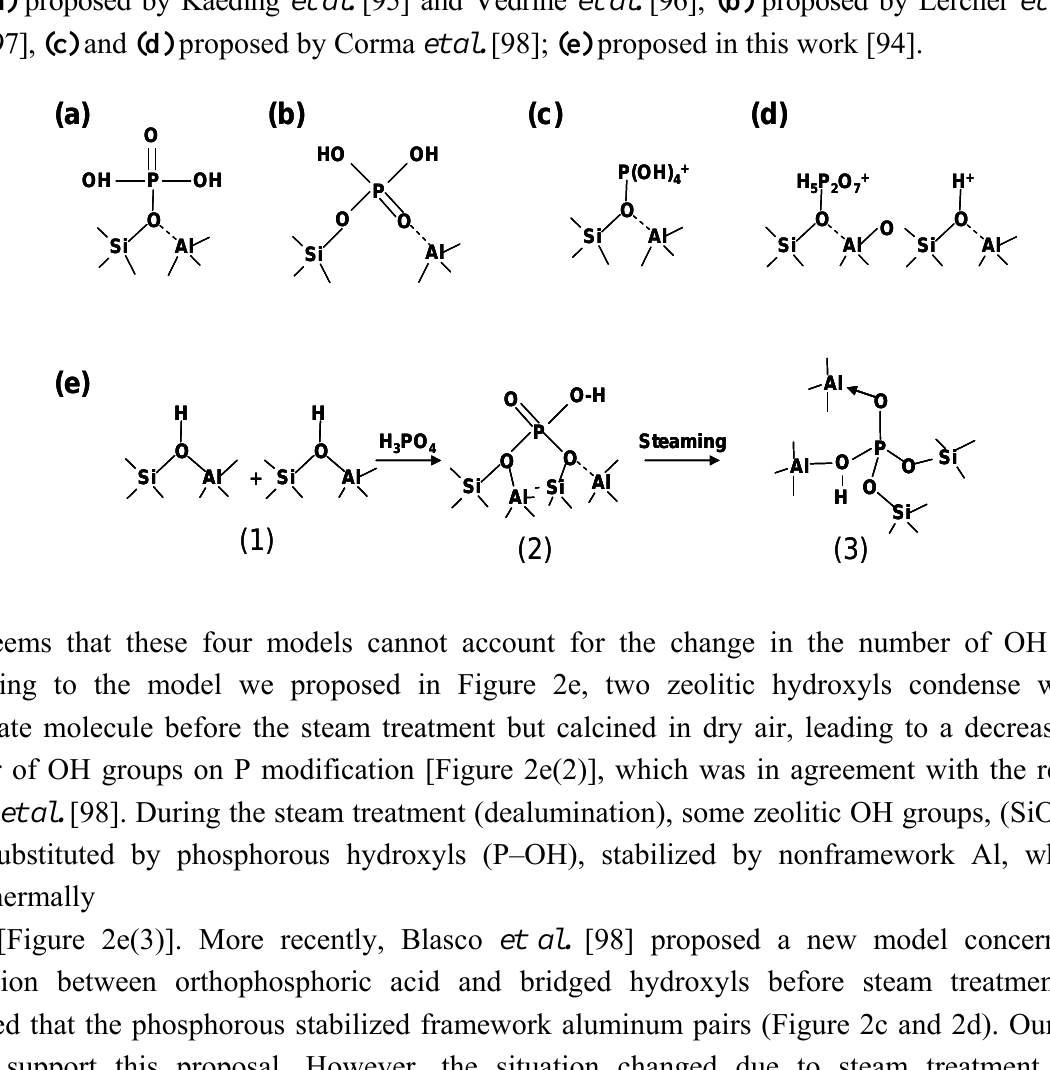
Figure 2. Models proposed for the interaction of phosphorus with the Brönsted acid sites of HZSM-5 prepared by impregnation with phosphorus modifiers and